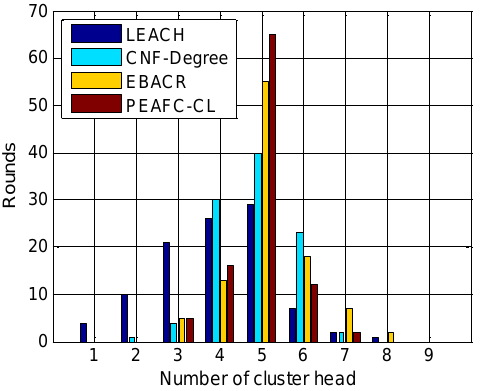
Figure 9. Comparison of the statistics of the number of CHs formed.